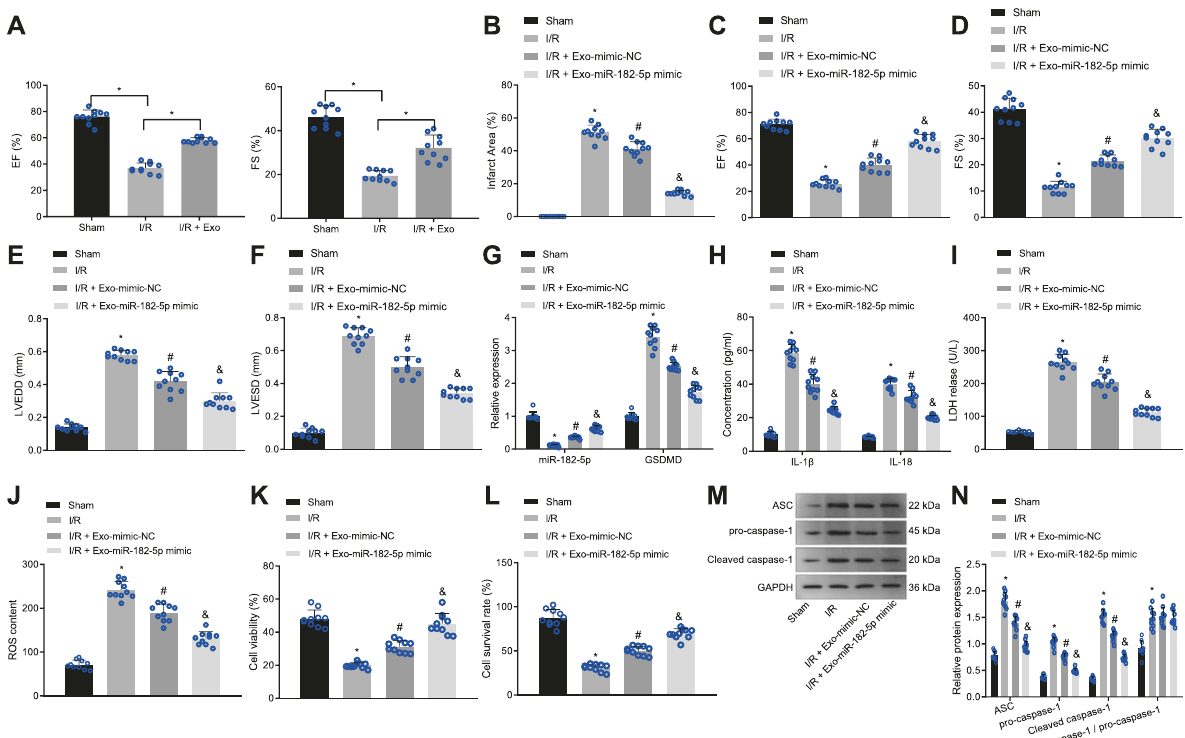
Fig. 7 Exosomal miR-182-5p from MSCs diminishes I/R-induced myocardial cell pyroptosis and delays I/R injury in vivo. I/R-treated mice were injected with exo-miR-182-5p mimic (exosomes derived from miR-182-5p mimic-transfected MSCs) or exo-mimic-NC (exosomes derived from mimic-NC-transfected MSCs). A The echocardiography of cardiac functions of I/R mice; B MI size diagram calculated by the cross- sectional imaging; C Determination of LVEF of I/R mice; D Determination of LVFS of I/R mice; E Determination of LVESD of I/R mice; F Determination of LVEDD of I/R mice; G The expression of miR-182-5p and GSDMD mRNA level in myocardial tissues of I/R mice detected by RT-qPCR, normalized to U6 and GAPDH respectively; H The levels of IL-1 β and IL-18 in myocardial tissue homogenate supernatant of I/R mice determined by ELISA; I LDH release in myocardial tissues of I/R mice detected by LDH kit; J ROS production in myocardial tissues of I/R mice measured by DCFH-DA; K The cell viability in myocardial tissues measured by Calcein-AM/PI double staining; L The cell survival rate in myocardial tissues of I/R mice measured by trypan blue staining; M Representative images of ASC, pro-caspase-1, and caspase-1 protein bands in myocardial tissues of I/R mice; N Western blot analysis of ASC, pro-caspase-1, and caspase-1 proteins in myocardial tissues of I/R mice, normalized to GAPDH. N = 10 for mice in each group. The comparison among multiple groups was conducted with one-way ANOVA, followed by Tukey ’ s post hoc test. Differences among groups at different time points were conducted by repeated-measures ANOVA with Bonferroni correction. * P < 0.05 vs. sham-operated mice. # P < 0.05 vs. I/R-treated mice. & P < 0.05 vs. I/R-treated mice injected with